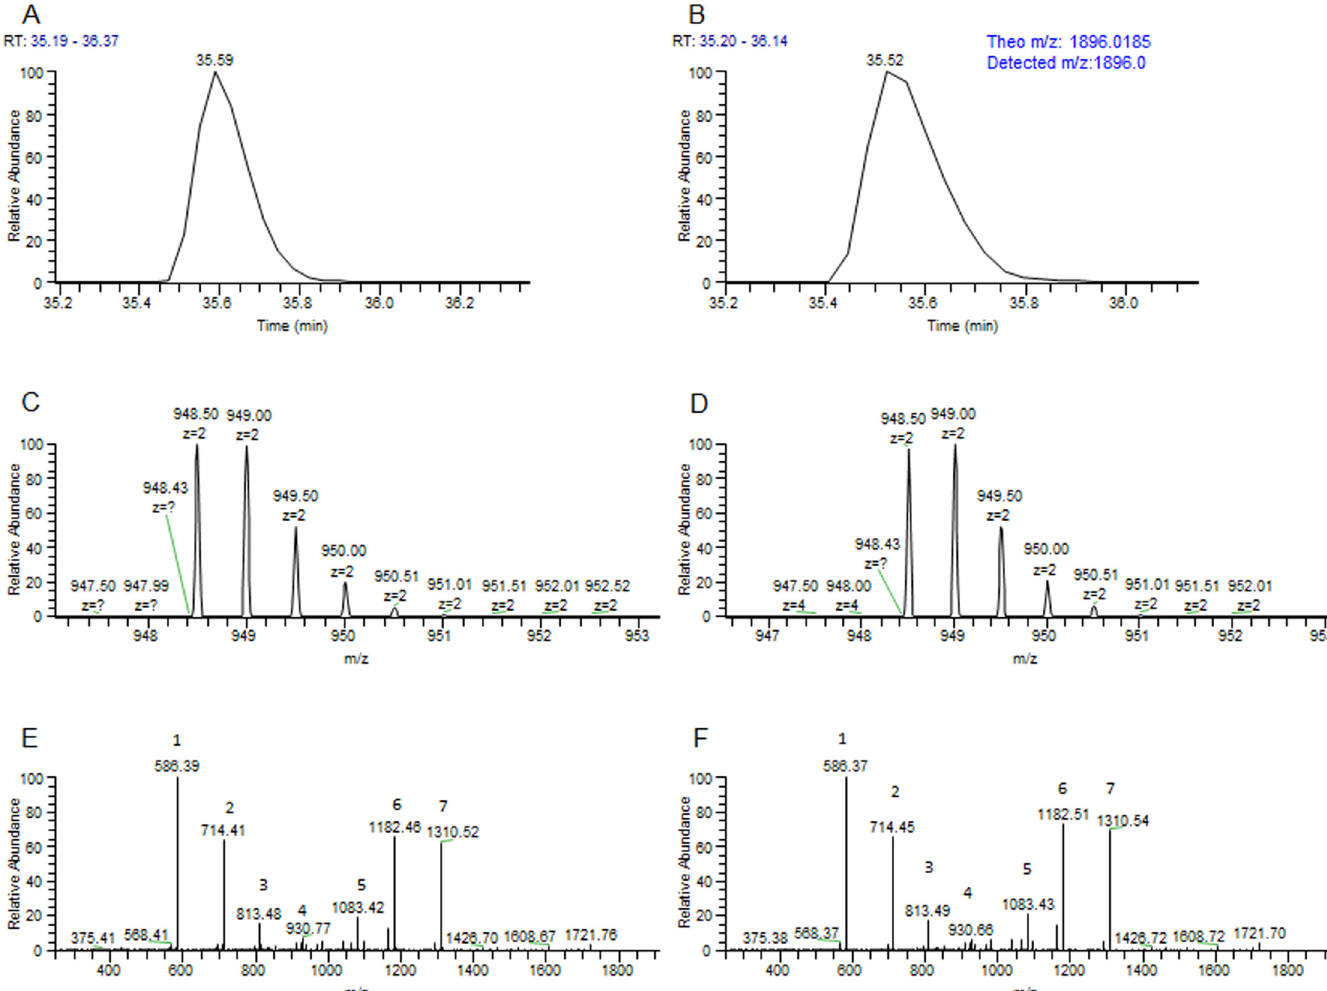
Fig 7. Upper panel: H1 peak (properly processed N-terminus corresponding to EVQLLESGGGLVQPGGSLR) after UPLC separation of tryptic peptides of clone 2 scFv.Fc expressed in bacteria (A) and 293F cells (B). Peak corresponding to the estimated molecular weight of a correctly matured N-terminus is shown. Middle panel: (C) and (D) MS spectra of (A) and (B) in the upper panel. The estimated molecular weight for the H1 peptide with a charge of +1 is expected to be 1896.0185 da. The m/z of the major peaks in (C) and (D) correspond closely to the peptides shown in (A) and (B), respectively. Lower panel: (E) and (F) ms/ms spectra of the same sample in (A) and (B). The different peptides that the labelled peaks correspond to are as follows: Peak 1: PGGSLR; peak 2: QPGGSLR; peak 3: VQPGGSLR; peak 4: EVQLLESG; peak 5: SGGGLVQPGGSLR; peak 6: LESGGGLVQPGGSLR and peak 7: LLESGGGLVQPGGSLR. Automated and manual search for improperly processed signal peptide yielded only about 0.4% of AMA-H1 peptide in scFv.Fc purified from 293F cells (not